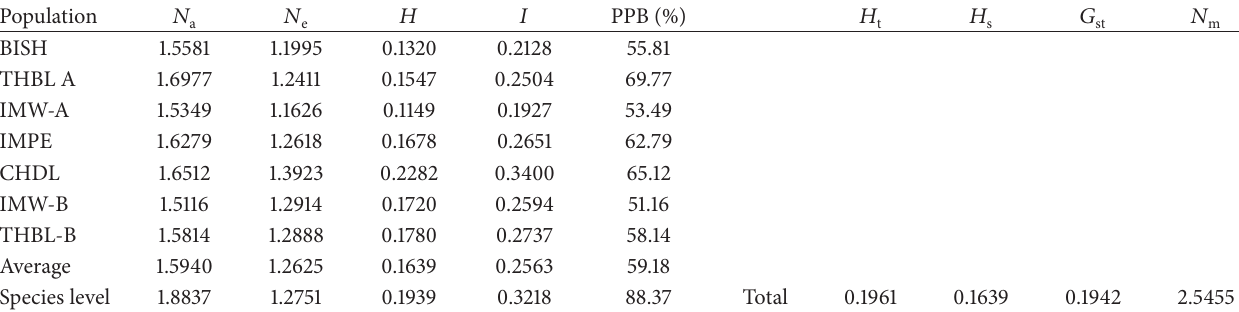
Table 2: Genetic diversity within populations and genetic differentiation parameters of seven populations of M. baccifera .